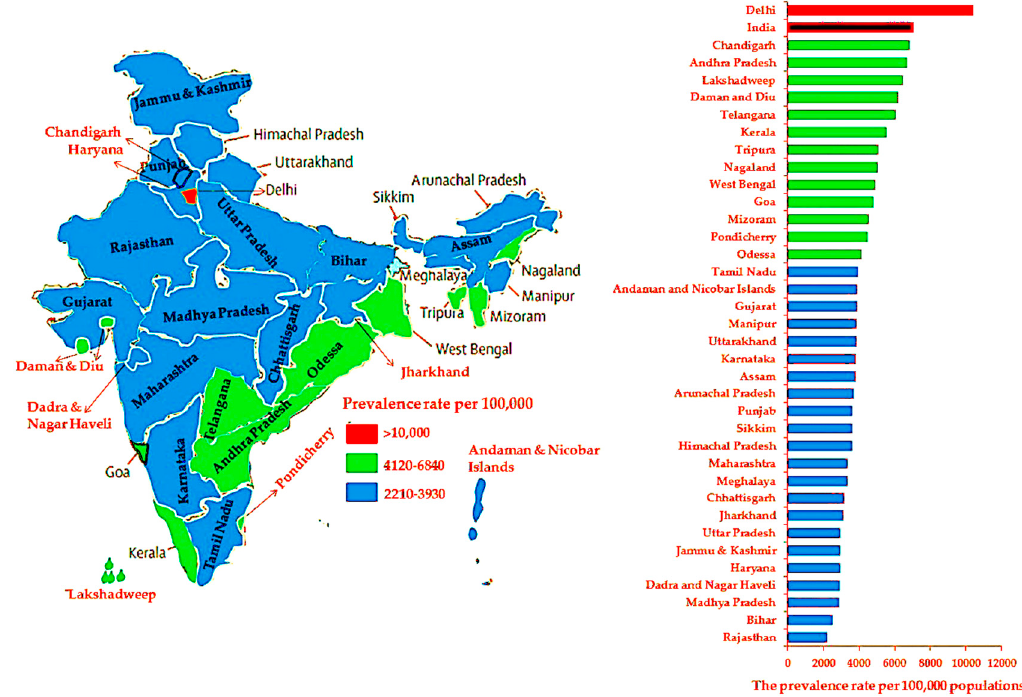
Figure 6. The prevalence rates of diabetes among adults at the national level and per state and union